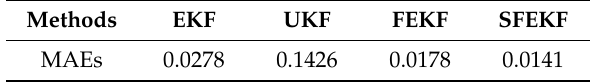
Table 1. The mean absolute errors (MAEs) of four comparison methods.